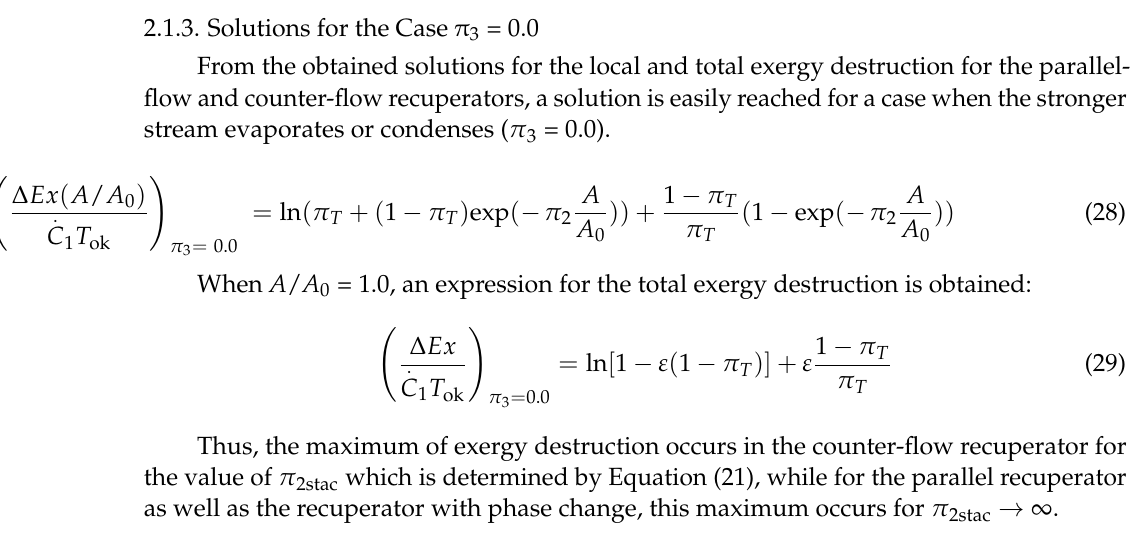
Figure 3. Characteristic π 2 values and temperature streams in the counter-flow recuperators A, B and C: ( a ) Δ T out > 0. ( b ) Δ T out = 0. ( c ) Δ T out < 0.